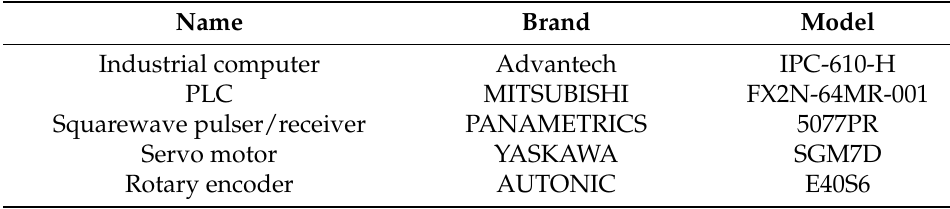
Figure 9. Appearance of testing equipment (( a ) testing equipment: 1. rotary encoder, 2. water pipe, 3. detection cantilever, 4. transmitting and receiving transducers, 5. solid propellant, 6. me- chanical transmission link, 7. water tank, 8. transmitter/receiver unit, and 9. industrial computer), ( b ) transducer and propellant). Table 5. Details of the industrial control